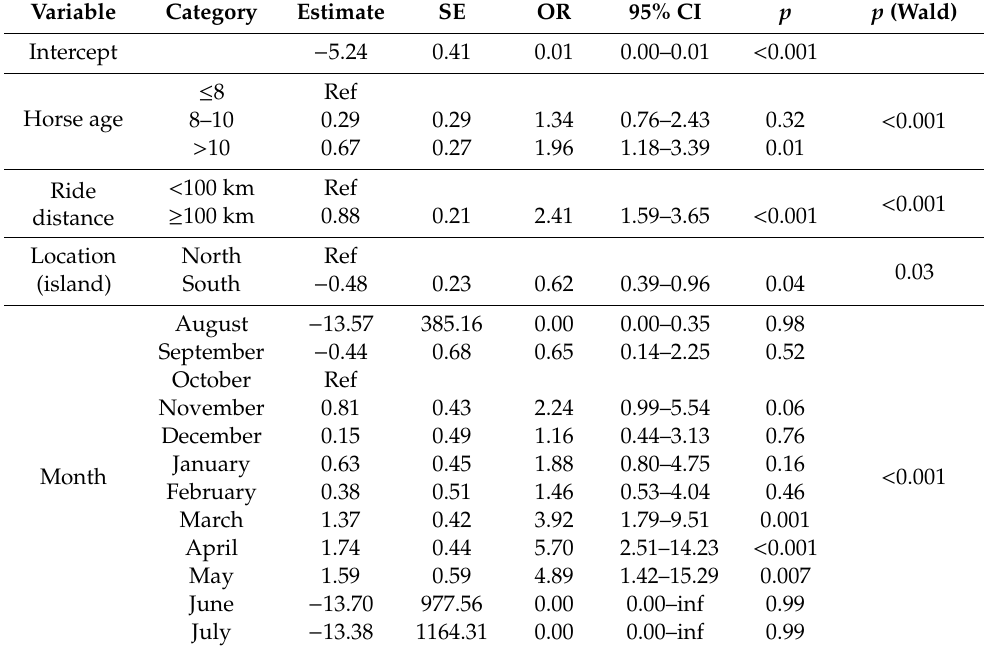
Table 6. Multivariate logistic regression model of associations between ride elimination (No / Yes) due to metabolic reasons only and predictor variables; horse age, ride distance, location and time of